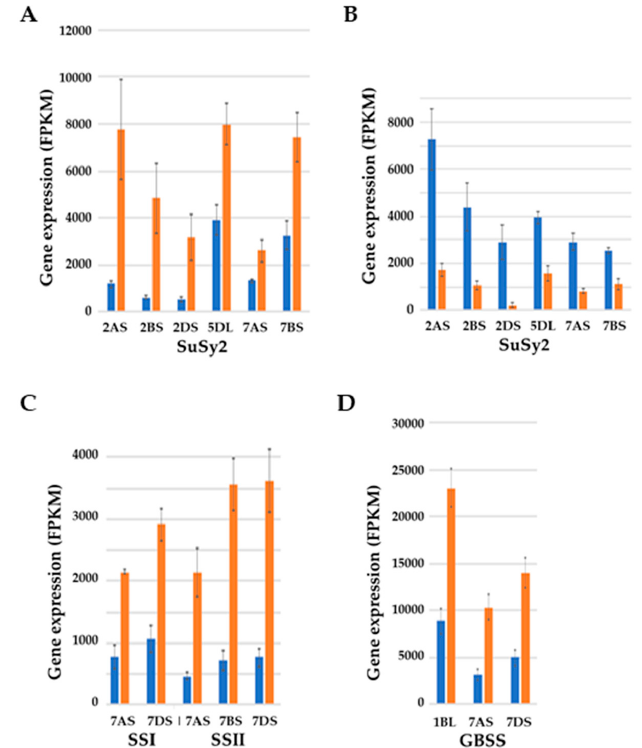
Figure 8. Graphical representation (means and standard errors) showing the effects of sulphur on the expression levels (FPKM) of selected genes in developing grain of wheat ( Triticum aestivum ) genotype SR3 at 21 days post-anthesis. Sulphur was either supplied (blue columns) or withheld (brown columns). Results for each homeologue are shown separately, with chromosomal locations indicated. ( A , B ) Sucrose synthase ( SuSy2 ) expression in the endosperm and embryo, respectively. The increase in expression in the endosperm in response to sulphur deficiency was significant ( p < 0.01 for the 5DL, 7AS, and 7BS genes; p < 0.001 for the 2AS, 2BS, and 2DS genes), as was the decrease in expression in the embryo ( p < 0.01 for the 5DL and 7BS genes, p < 0.001 for all others). ( C,D ) Soluble and granule-bound starch synthase gene expression, respectively, in the endosperm. The increase in expression in response to sulphur deficiency was significant for all of the genes and homeologues shown ( p < 0.01 for all SSI genes, p < 0.001 for all SSII genes, p < 0.001 for all GBSS genes). Plotted from RNA-seq data provided in